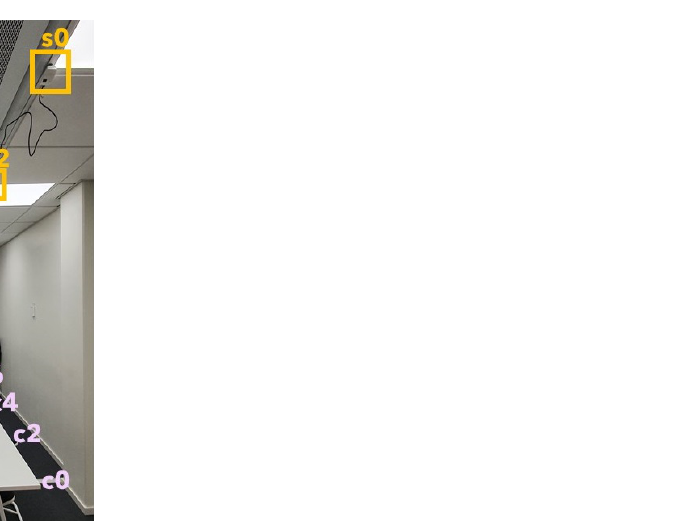
Figure 1. Setup of the test room. The numbered multiple heat sensor are seen on the ceiling. The chairs are numbered in order to keep the occupant positions in the data set for validation.